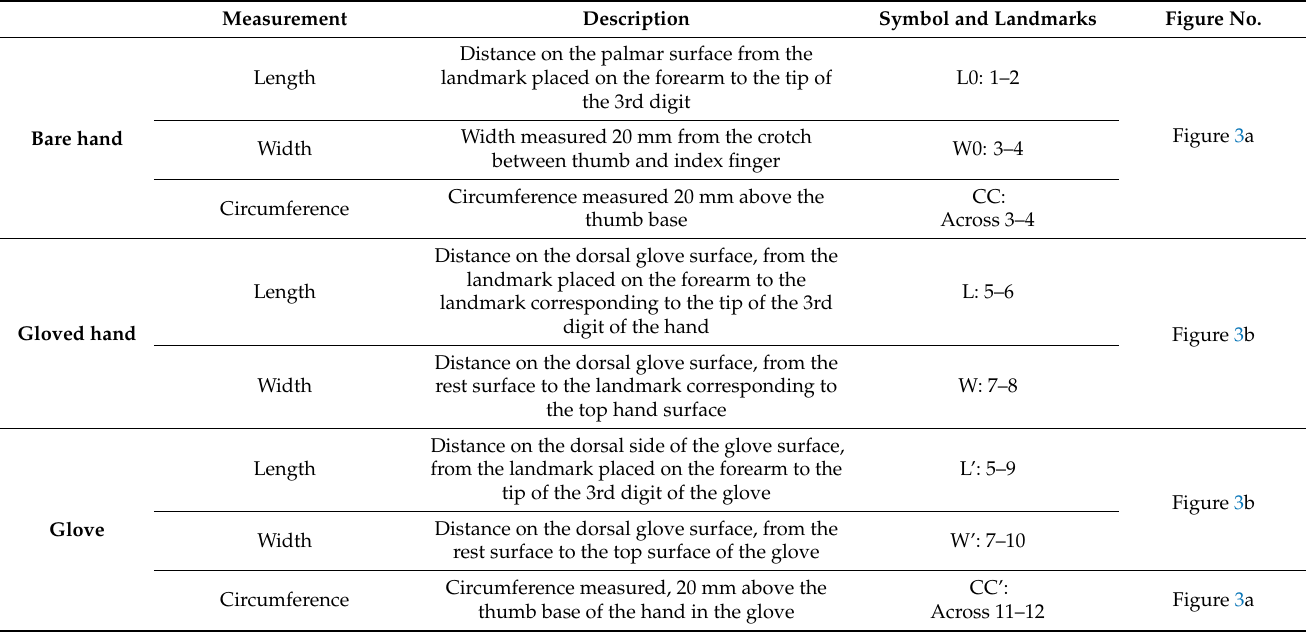
Table 1. The description of the linear and circumference measurements with reference points for 3D scans